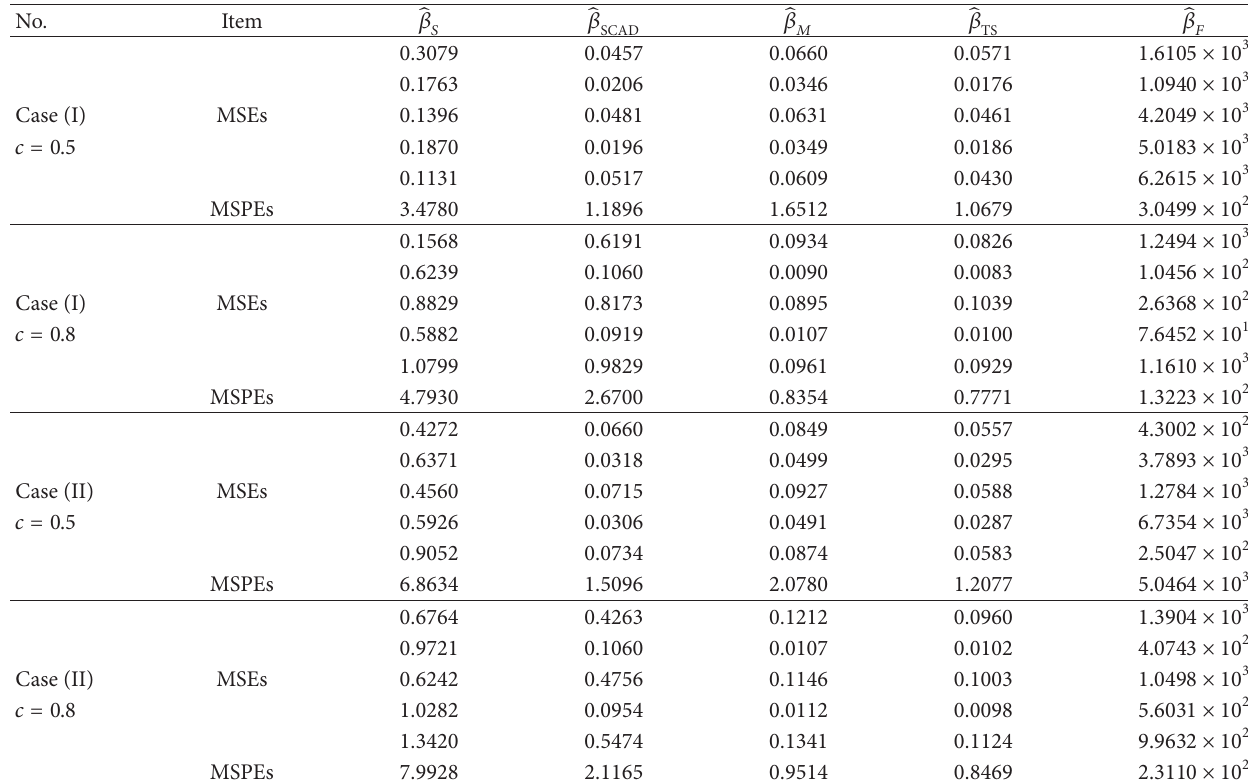
T 1: MSEs on the parameter and MSPEs of the two-stage adjusted linear model (12) compared with the submodel, the SCAD-penalized model, the multistep adjusted model and the full model. 𝛽𝛽